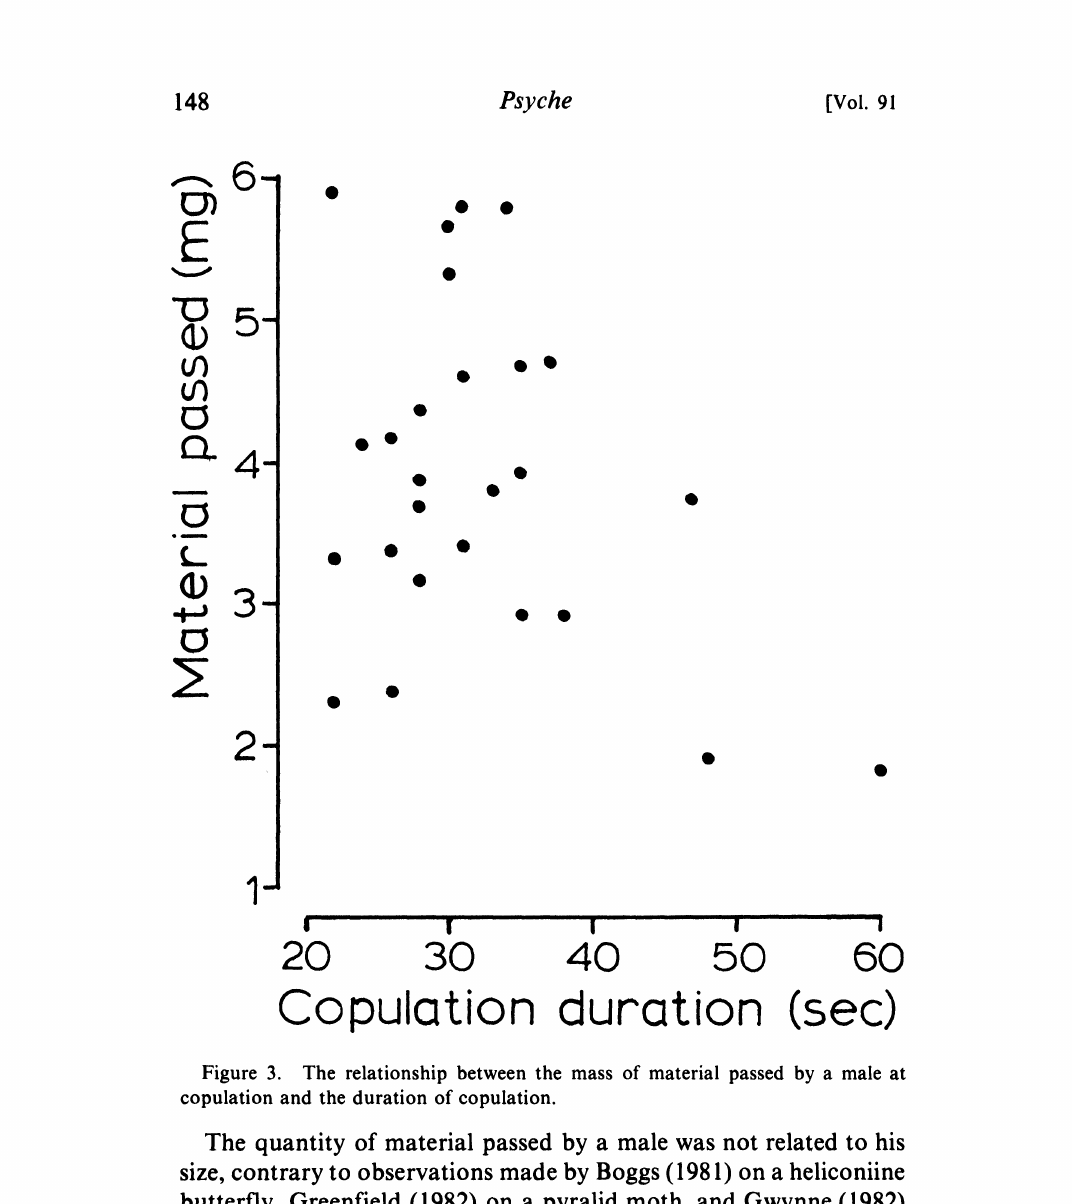
Figure 3. The relationship between the mass of material passed by a male at copulation and the duration of copulation. The quantity of material passed by a male was not related to